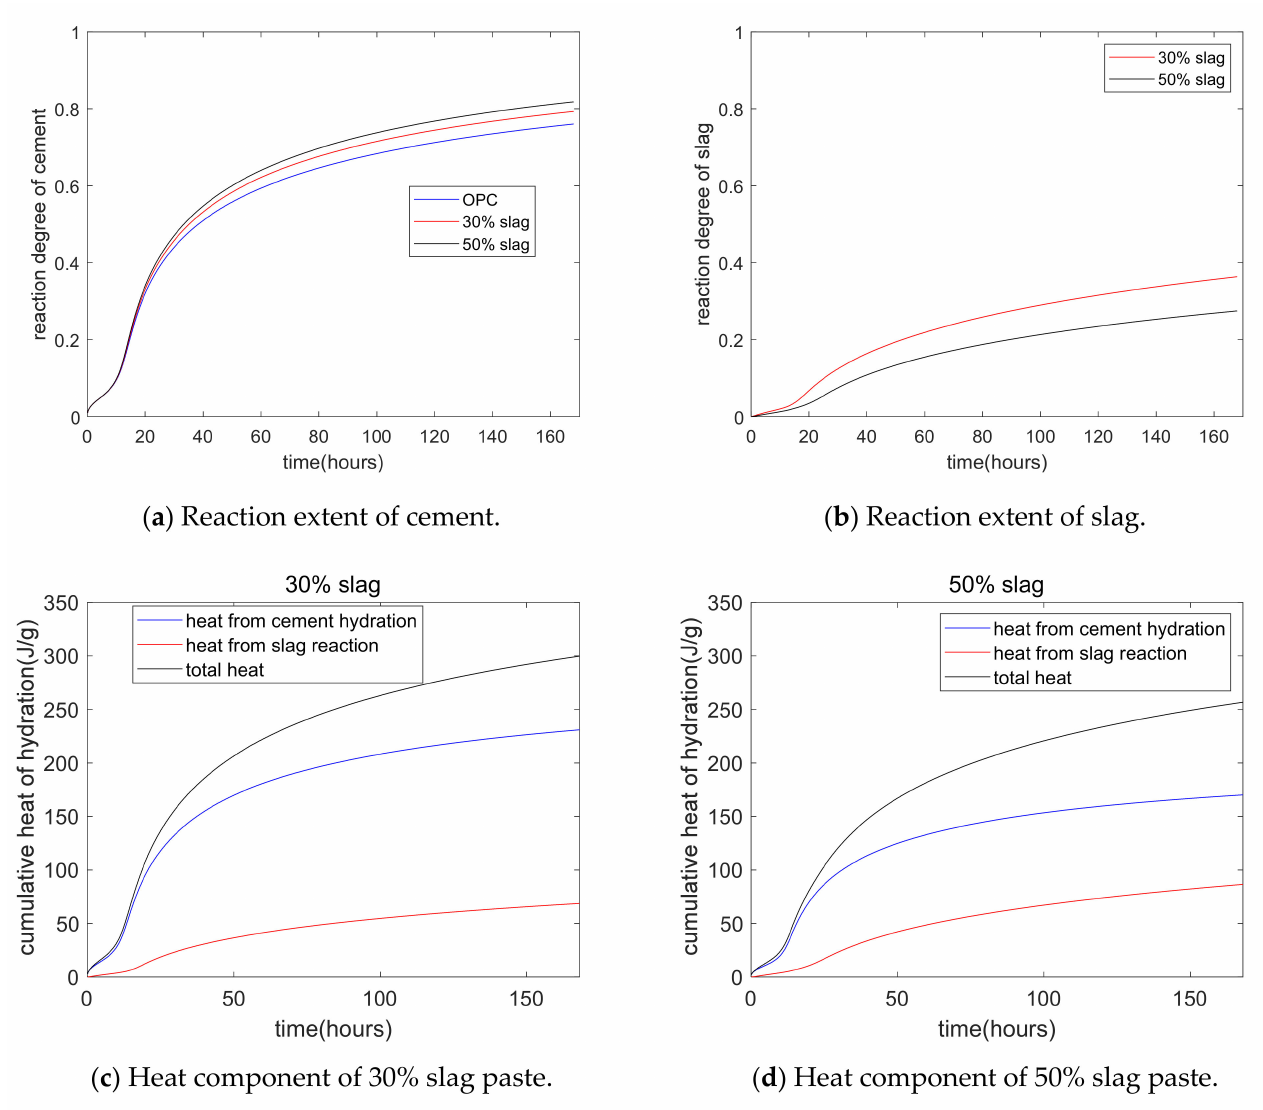
Figure 5. Parameter analysis of the hydration